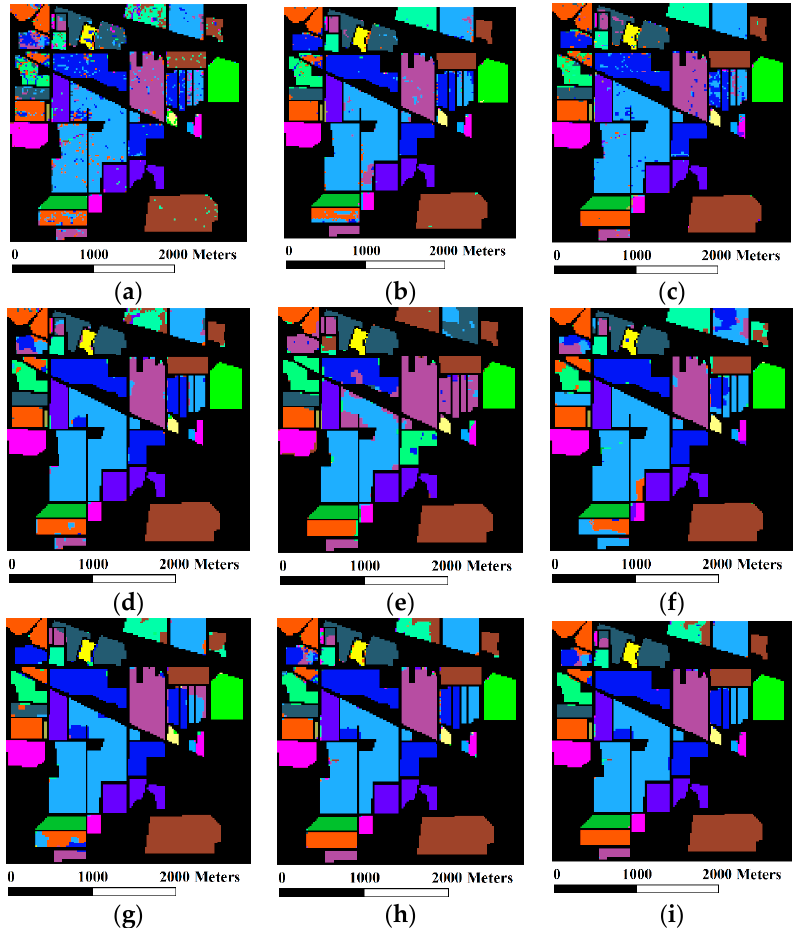
Figure 3. Classification maps for the Indian Pines data set by different methods: ( a ) SVM; ( b ) SS-Kernel; ( c ) EMP; ( d ) EPF_JBF; ( e ) MLR-LORSAL; ( f ) LBP-AL; ( g ) LORSAL-AL-MLL; ( h ) CS-GC; and ( i ) CS-GC + JBF.